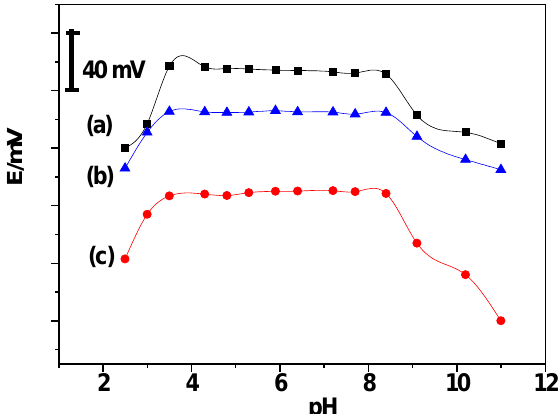
Figure 3. Potential/pH plots for ( a ) C/GO/Ca 2+ -ISEs; ( b ) C/PPY/Ca 2+ -ISEs; and ( c ) C/Ca 2+ -ISEs. Table 2. Potentiometric selectivity coefficient Log K potCa2+,J for the proposed calcium-ISEs. Sensor Type